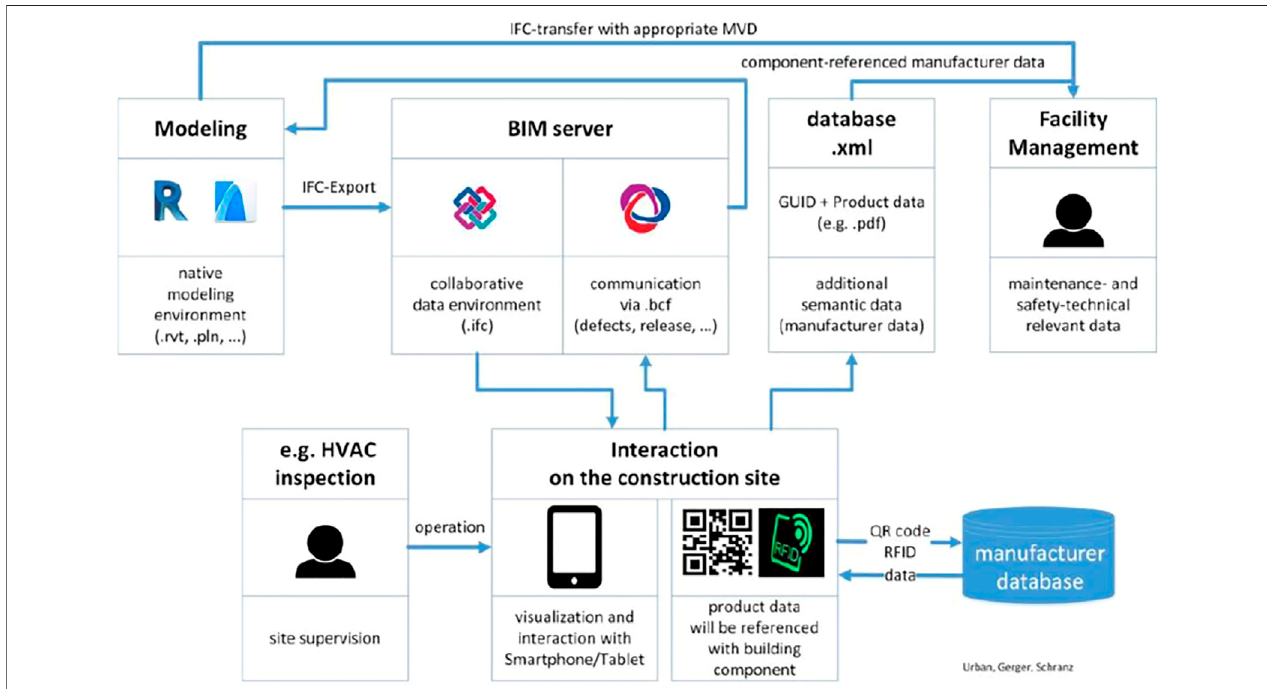
FIGURE 5 | On-site inspection: closed-loop data transfer between BIM and AR (adapted from Schranz et al. (2020)).